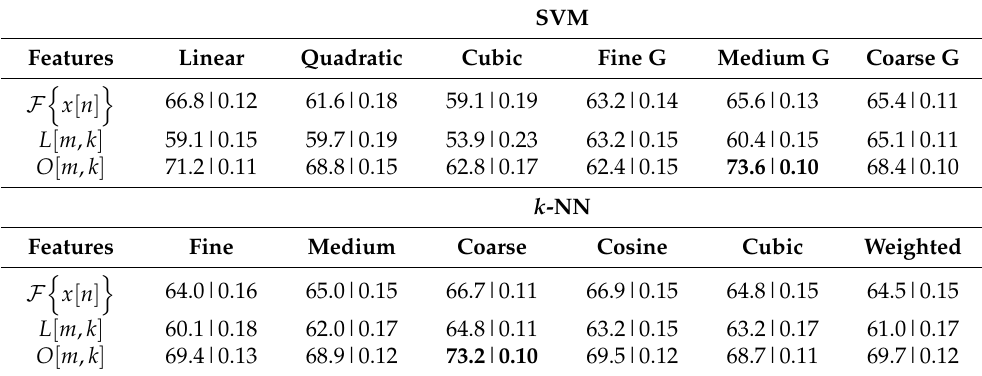
Table 6. Non-linear wear-state classification results ( % ) and normalised MAE for STFT data, where G denotes Gaussian.